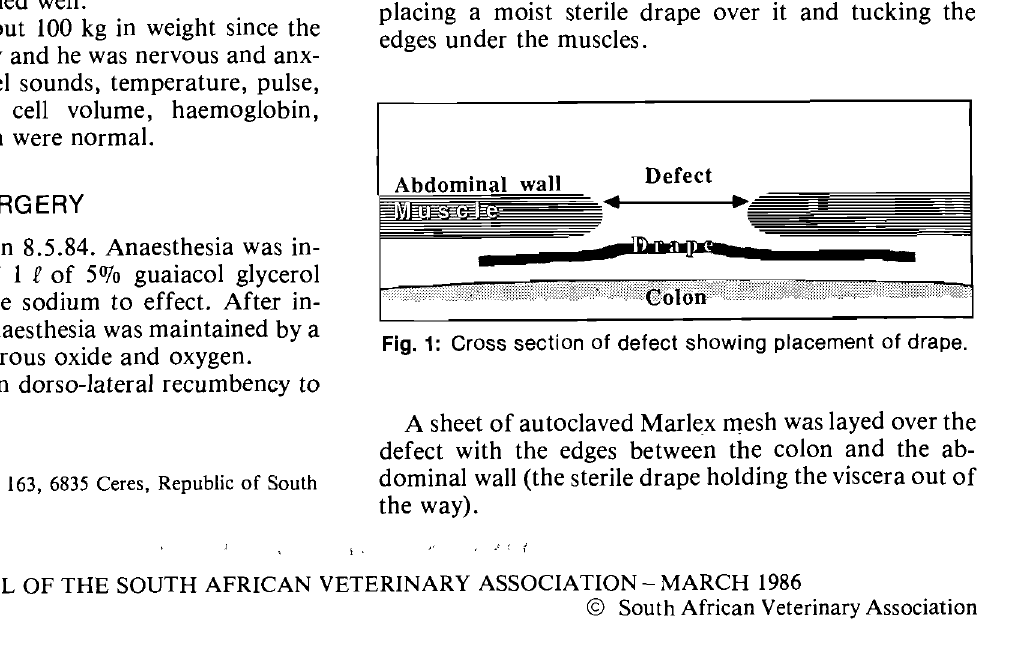
Fig. 1: Cross section of defect showing placement of drape.